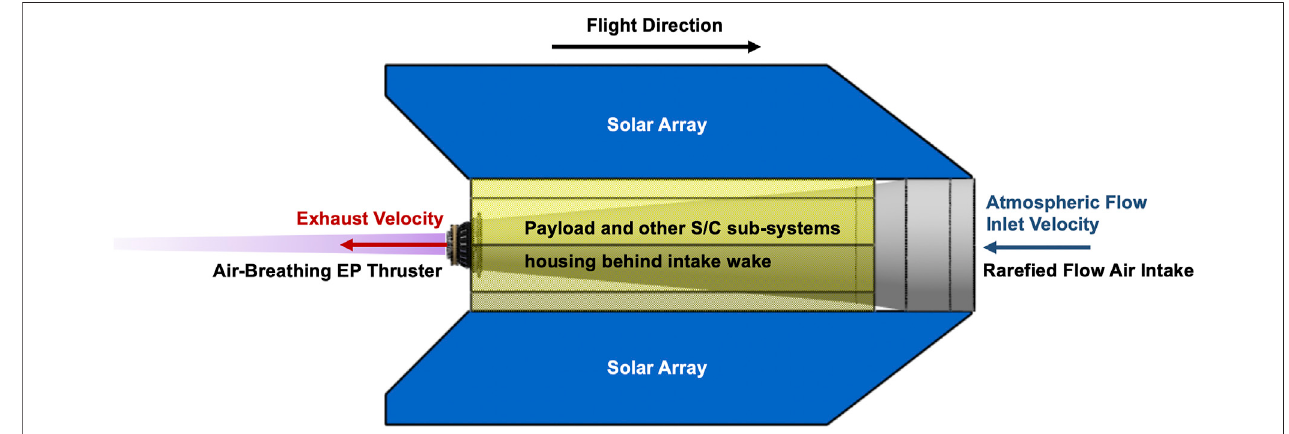
FIGURE 2 | Air-breathing electric propulsion